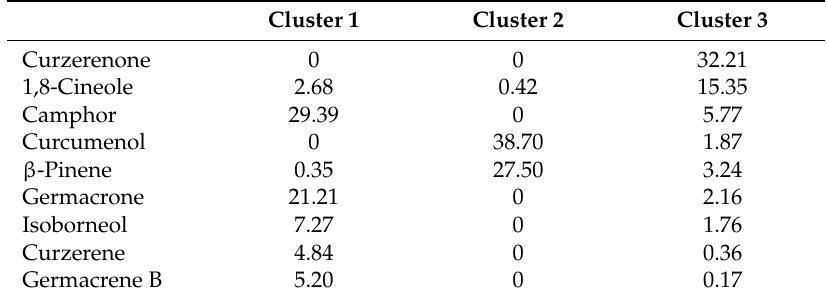
Table 9. Concentration (%) of centroids used in the cluster analysis of Curcuma aeruginosa rhizome